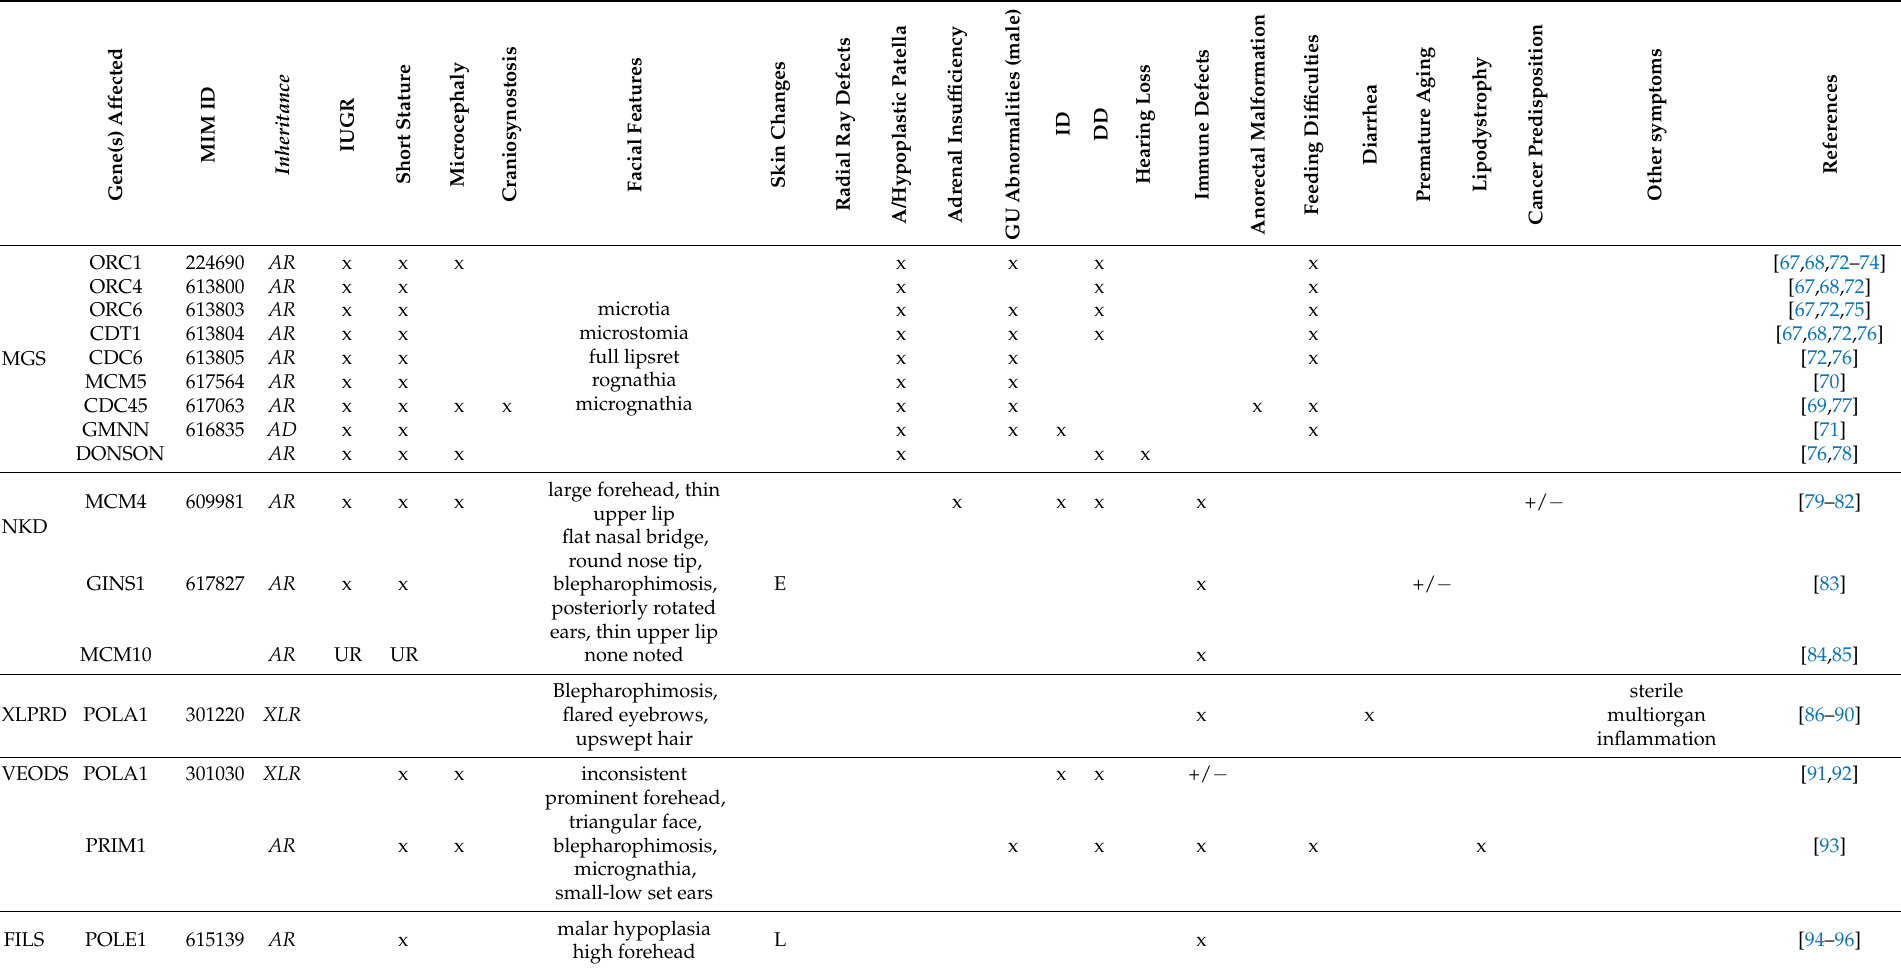
Table 1. Common symptoms occurring in diseases caused by defects in DNA replication. This table compiles common symptoms of diseases discussed in this review. A more exhaustive list of symptoms can be found in Supplementary Table